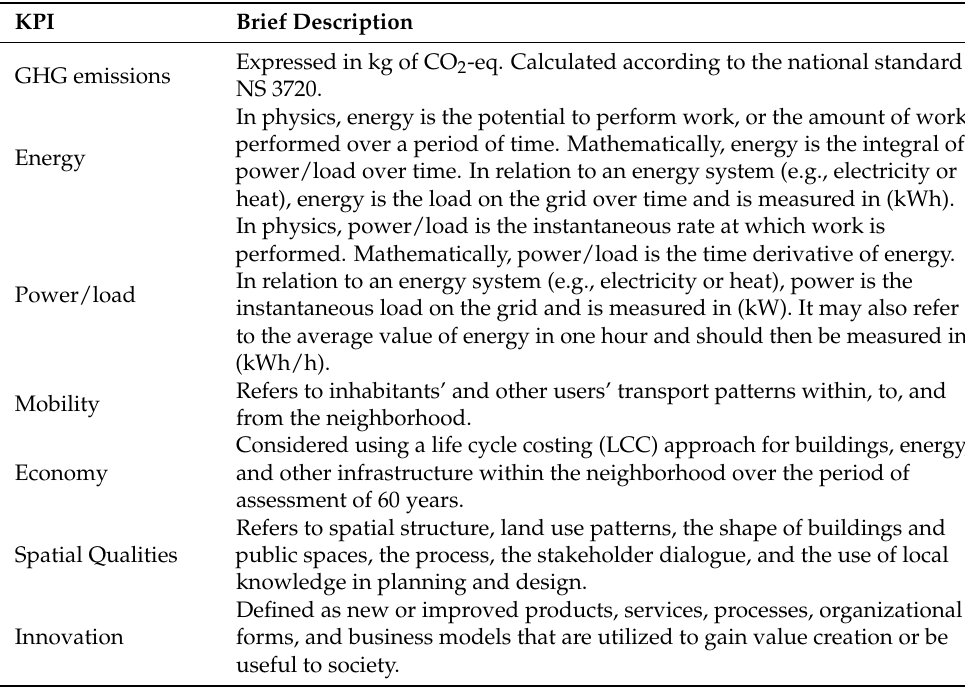
Table 1. Key Performance Indicators (KPIs): Brief description. Reproduced with permission from Wiik, Fjellheim et al. [4]. GHG = greenhouse